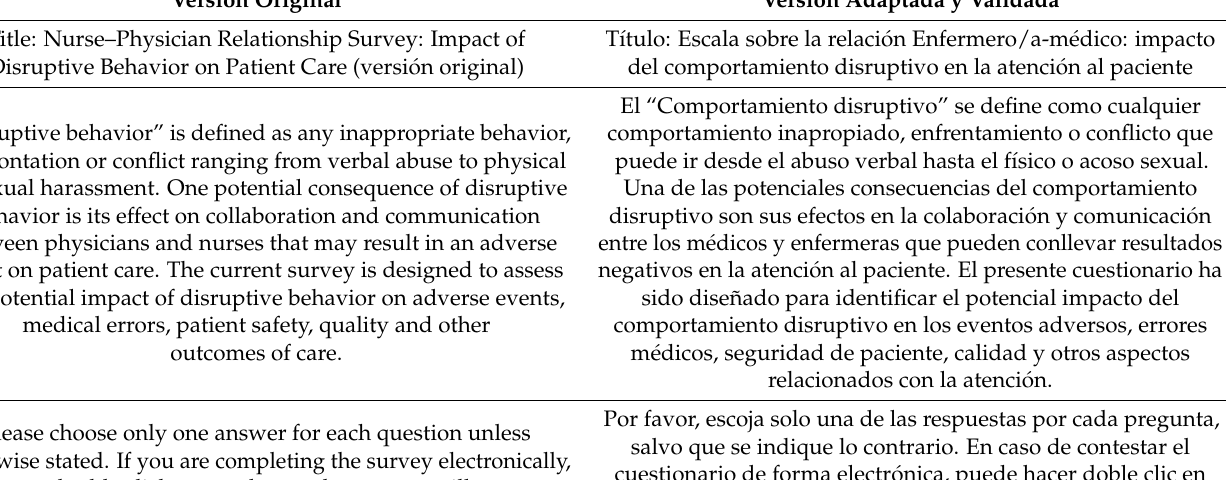
Table A1. Cuestionario adaptado—Versi ó n español/España. Versi ó n